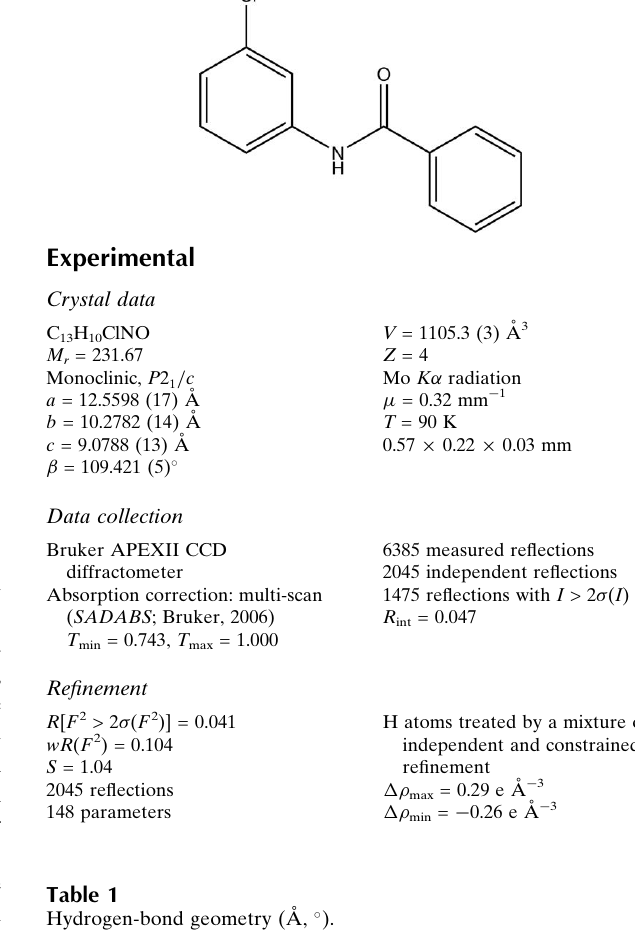
Hydrogen-bond geometry (A˚ , (cid:2)